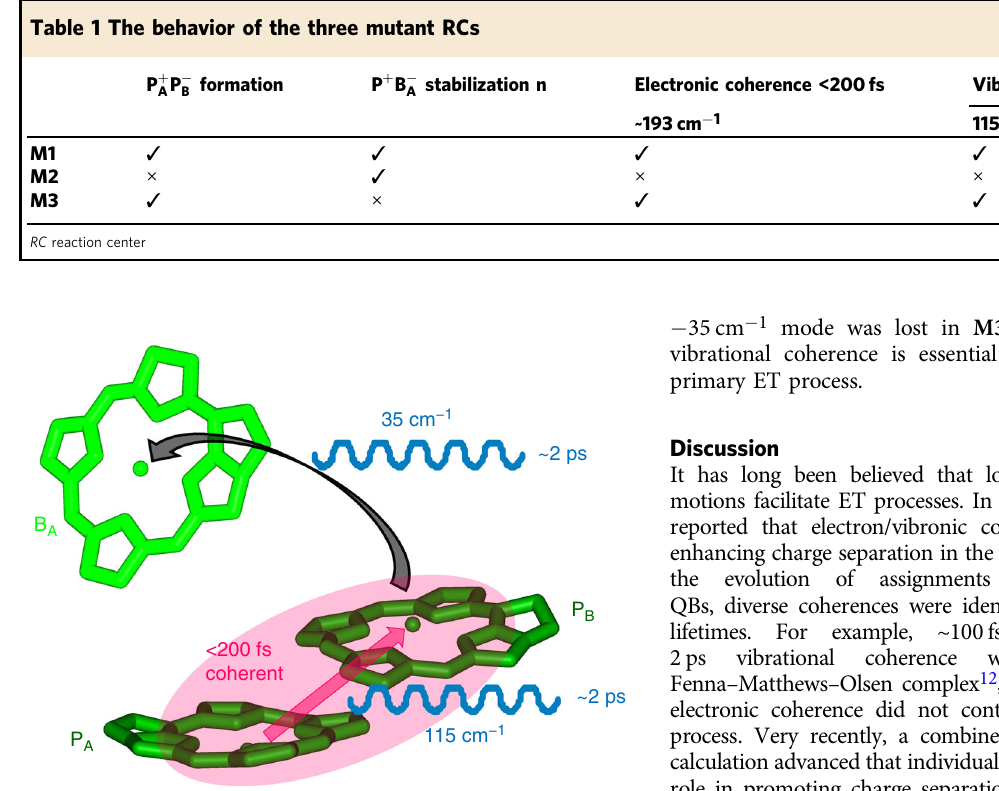
Fig. 5 Coherent primary electron transfer. A scheme of the primary electron transfer process facilitated by